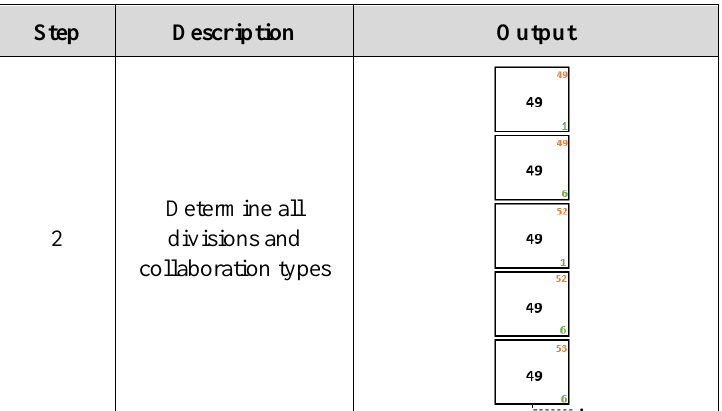
Table 7. Step 2/5 of detecting collaboration